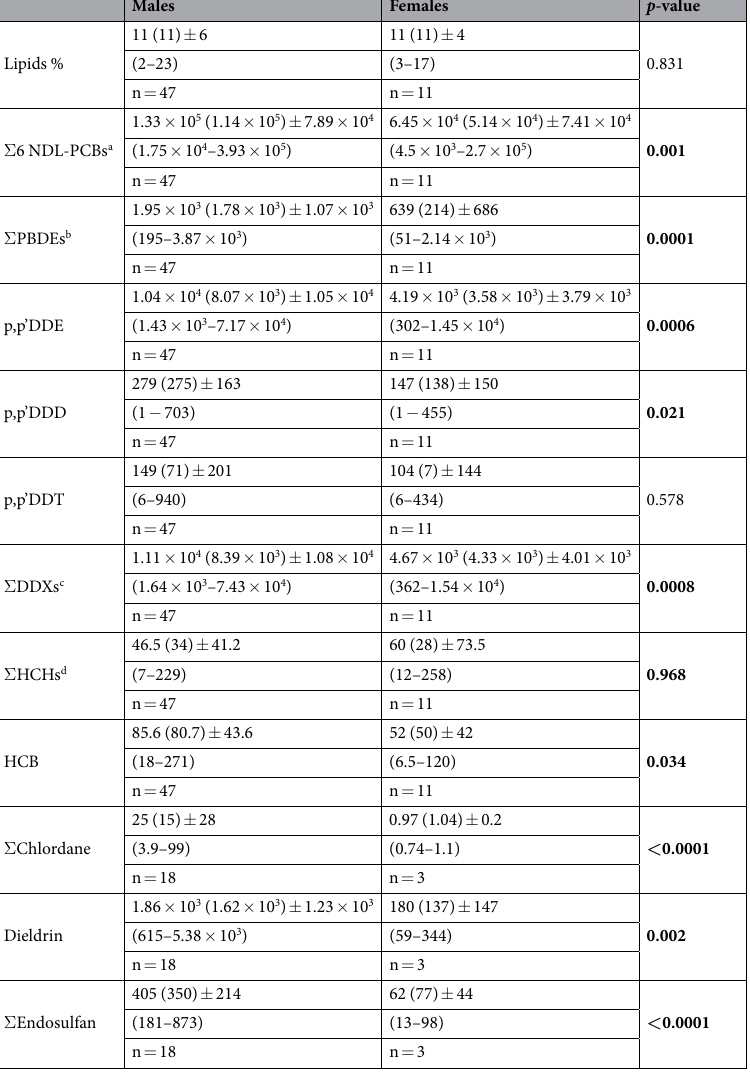
Table 1. Lipid percentage (%) and POP concentrations (ng.g − 1 lw) in the blubber biopsies of the bottlenose dolphins, Tursiops truncatus , from the Normanno-Breton Gulf. The data are presented as the mean (median) ± the standard deviation (min–max values) and the number of individuals (n). The differences between the males and females are shown as the p-values from the Mann-Whitney test. Significant p-values are in bold. a ∑ 6 NDL-PCBs: CB 28, CB 52, CB 101, CB 138, CB 153, and CB 180. b ∑ PBDEs: BDE 28, BDE 47, BDE 66, BDE 85, BDE 99, BDE 100, BDE 153, BDE 154 and BDE 183. c ∑ DDXs: o , p’ -DDT, p,p’-DDE, p , p’ -DDD, p , p’ -DDT, o , p’ DDE, and o , p’ DDD. d ∑ HCH: α -HCH, β -HCH, and γ